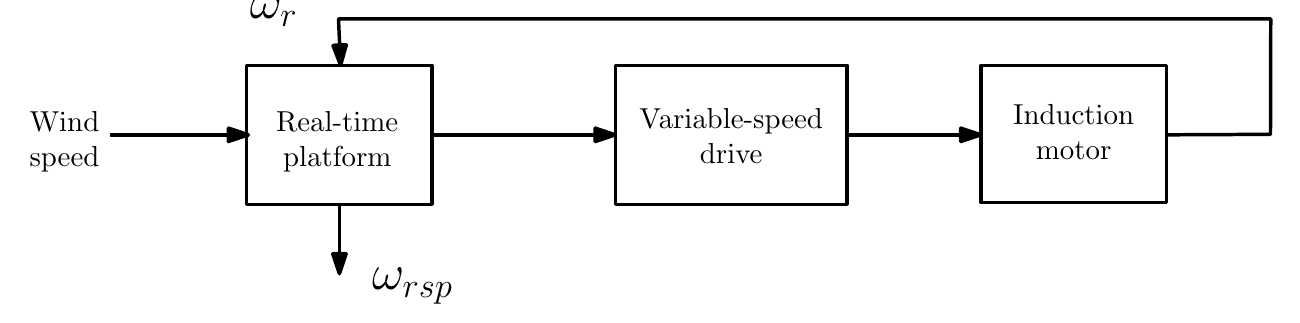
Figure 3. Wind turbine